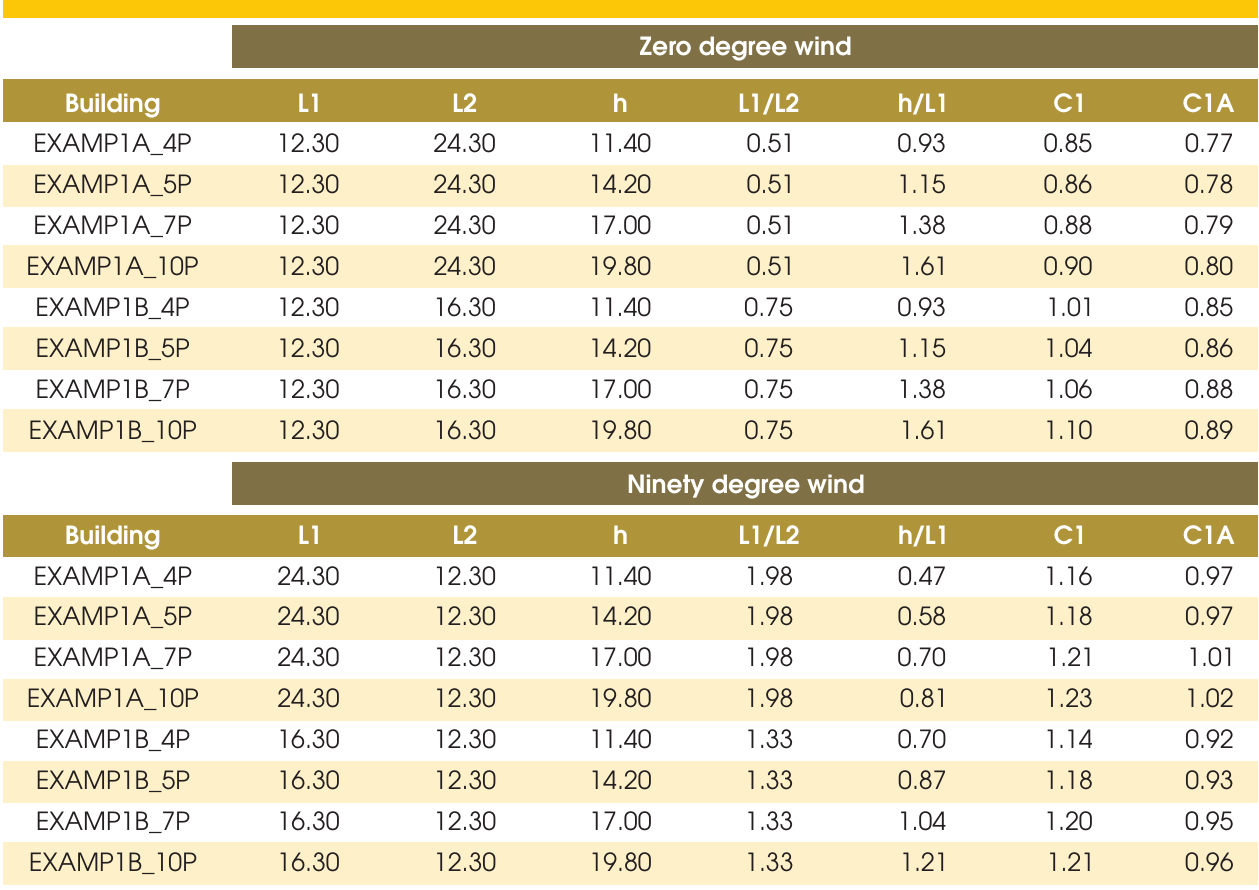
Table 3 – Drag coefficients of the buildings under